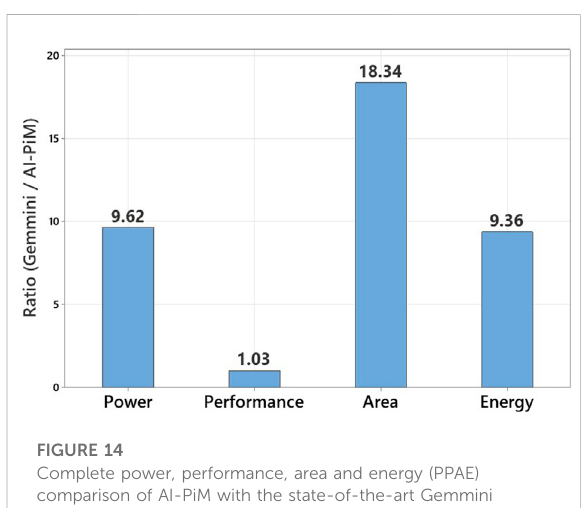
FIGURE 14 Complete power, performance, area and energy (PPAE) comparison of AI-PiM with the state-of-the-art Gemmini standalone AI